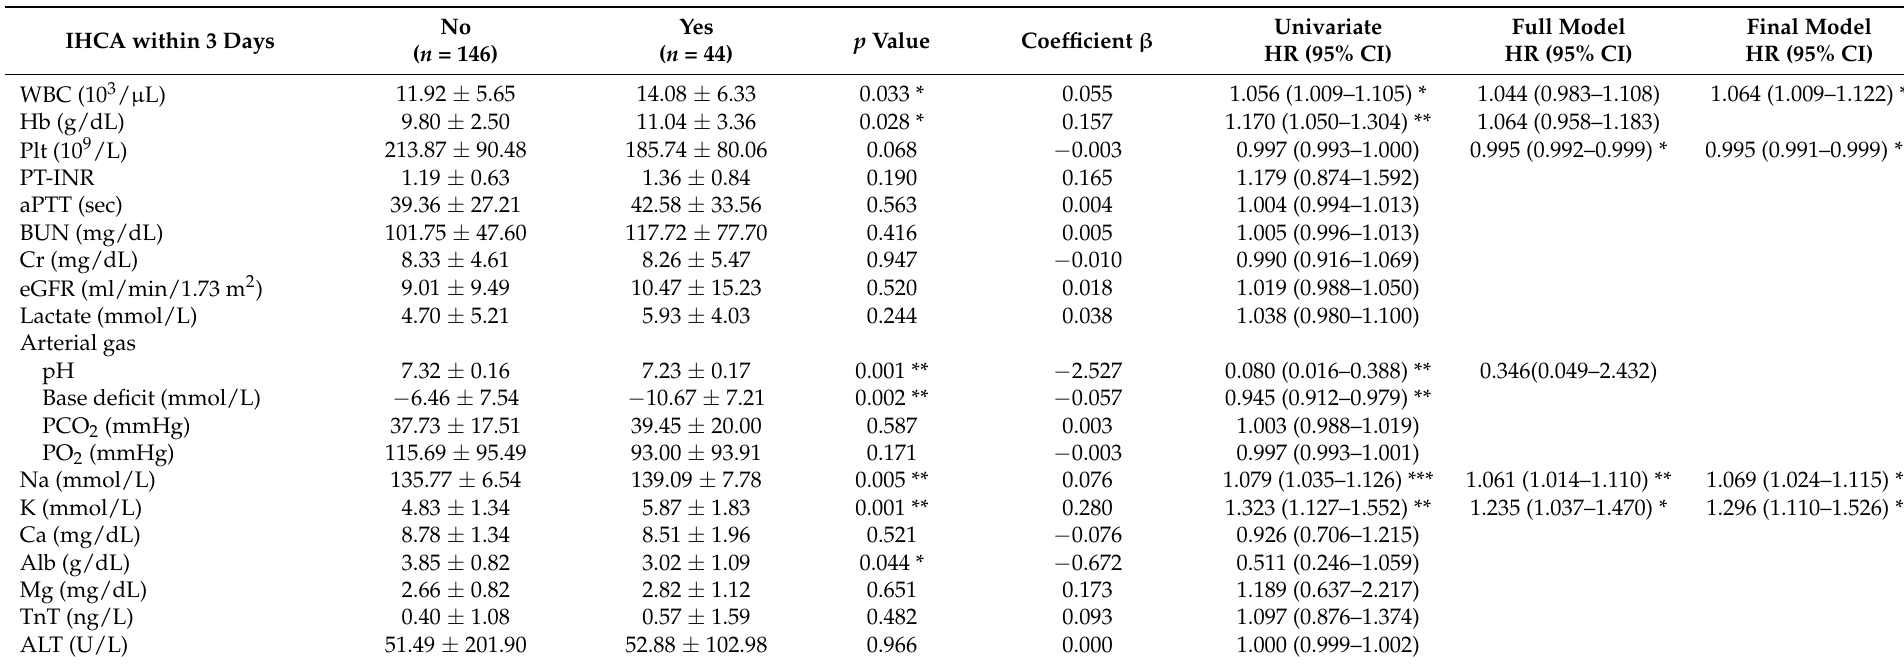
Table 3. The characteristics of the initial biochemistry results domain for the in-hospital cardiac arrest (IHCA) risk with COX